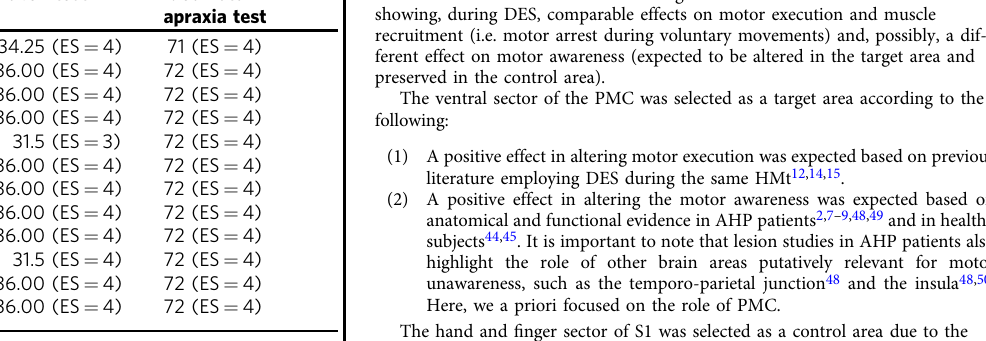
The table report the age/education-adjusted score and the equivalent score (ES) for each subject and for each test. ES = 0: de fi cit, ES = 2, 3, 4: normal performance. ID, identi fi cation number.